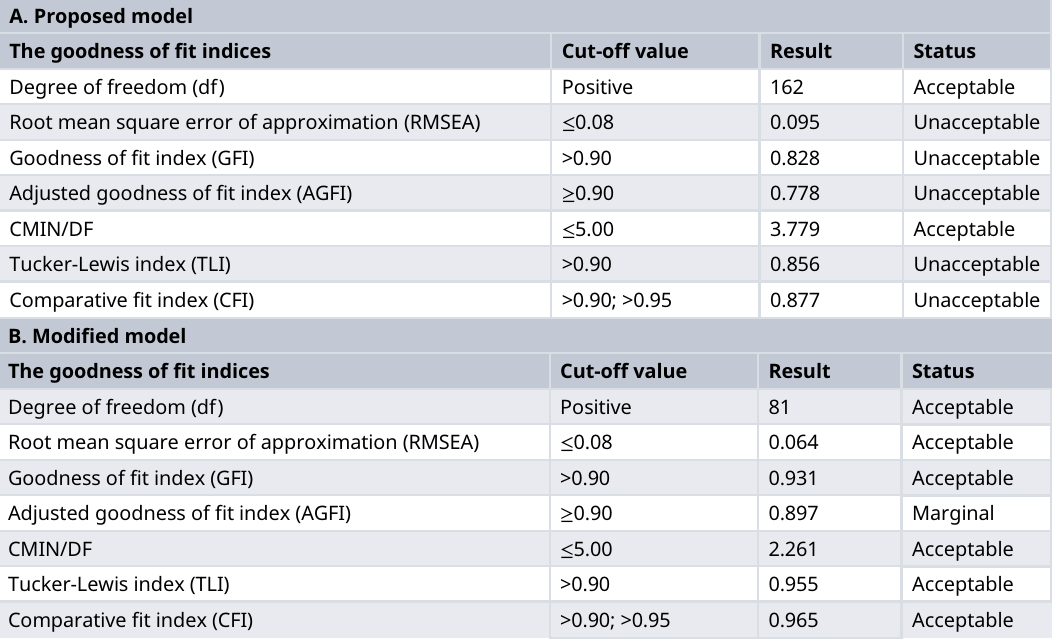
Table 3. Goodness of fit results of proposed and modified